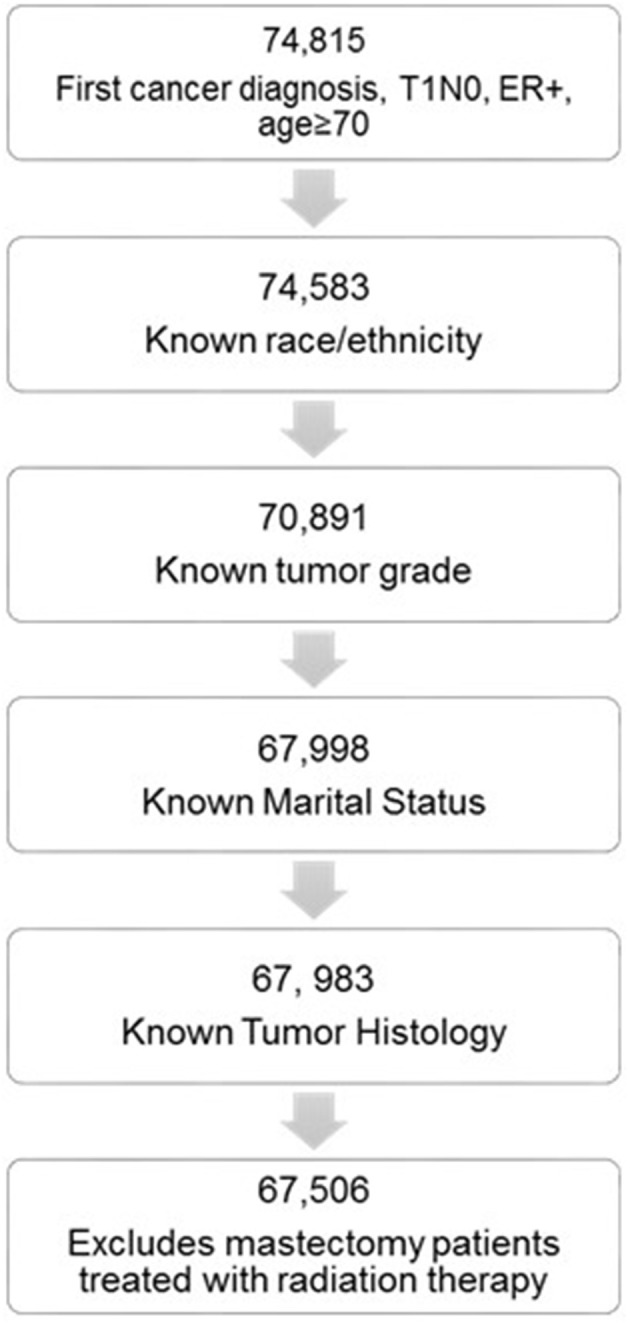
Flow diagram for analytic cohort.